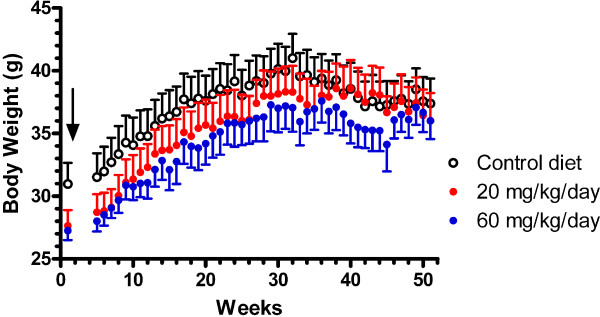
Chronic daily exposure to EVP-0015962 in Tg2576 mice is well tolerated. Body weight change in Tg2576 mice, measured weekly beginning the week prior to chronic dosing with EVP-0015962 in a food formulation at 20 or 60 mg/kg/day and continuing through the course of treatment. There are no group differences in body weight change (2-way repeated measures ANOVA, within subjects variable – week and between subjects variable – drug treatment). Data are the mean ± SEM of 6–8 mice per group. Arrow indicates the start of treatment with EVP-0015962.